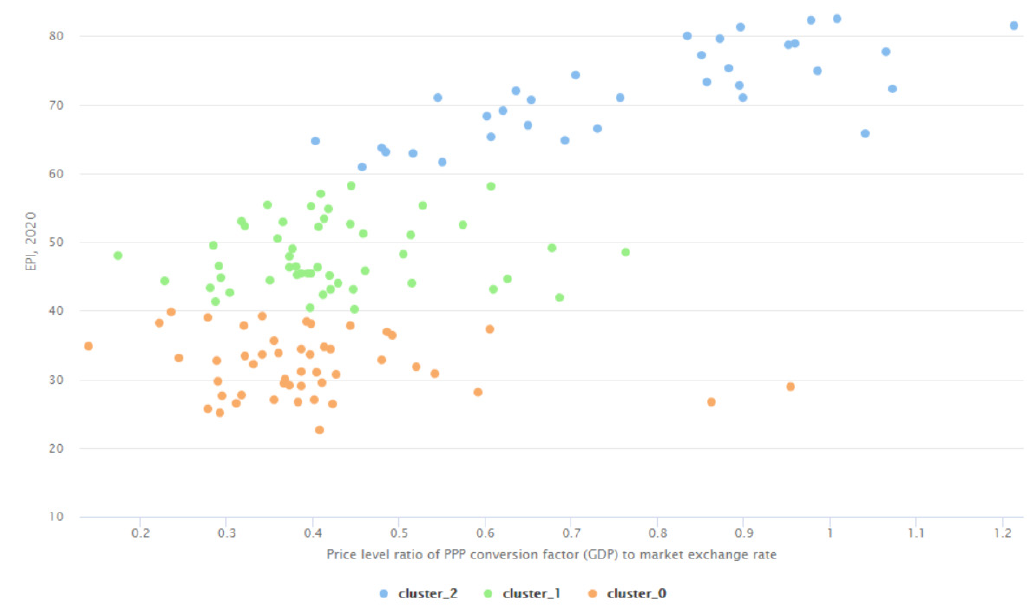
Figure 2. K-means model of clusterization of countries by